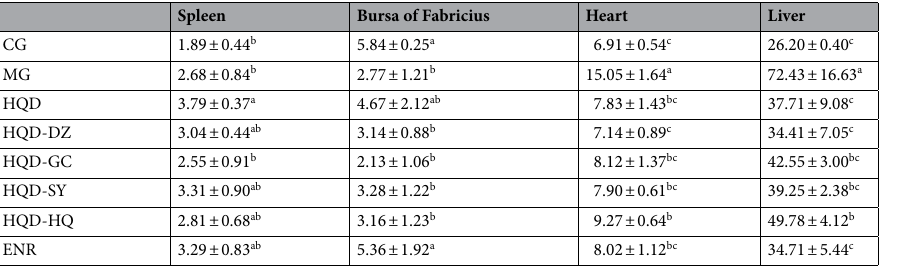
Table 1. Visceral index of chicks were shown in the table. The different letter superscript in the same column indicates that the difference is significant ( p < 0.05). CG, Control group; MG, Model group; DZ, Jujube, Jujubae Fructus ; HQ, Scutellaria baicalensis, Scutellariae Radix ; GC, liquorice, Licoric e; SY, Herbaceous peony, Paeoniae Radix Alba ; HQD, decoction consists of DZ, HQ, GC and SY; HQD-DZ, HQD absent of DZ; HQD-GC, HQD absent of GC; HQD-SY, HQD absent of SY; HQD-HQ, HQD absent of HQ; ENR, Enrofloxacin group. (The dosage of Chinese medicine was 500 mg/kg).